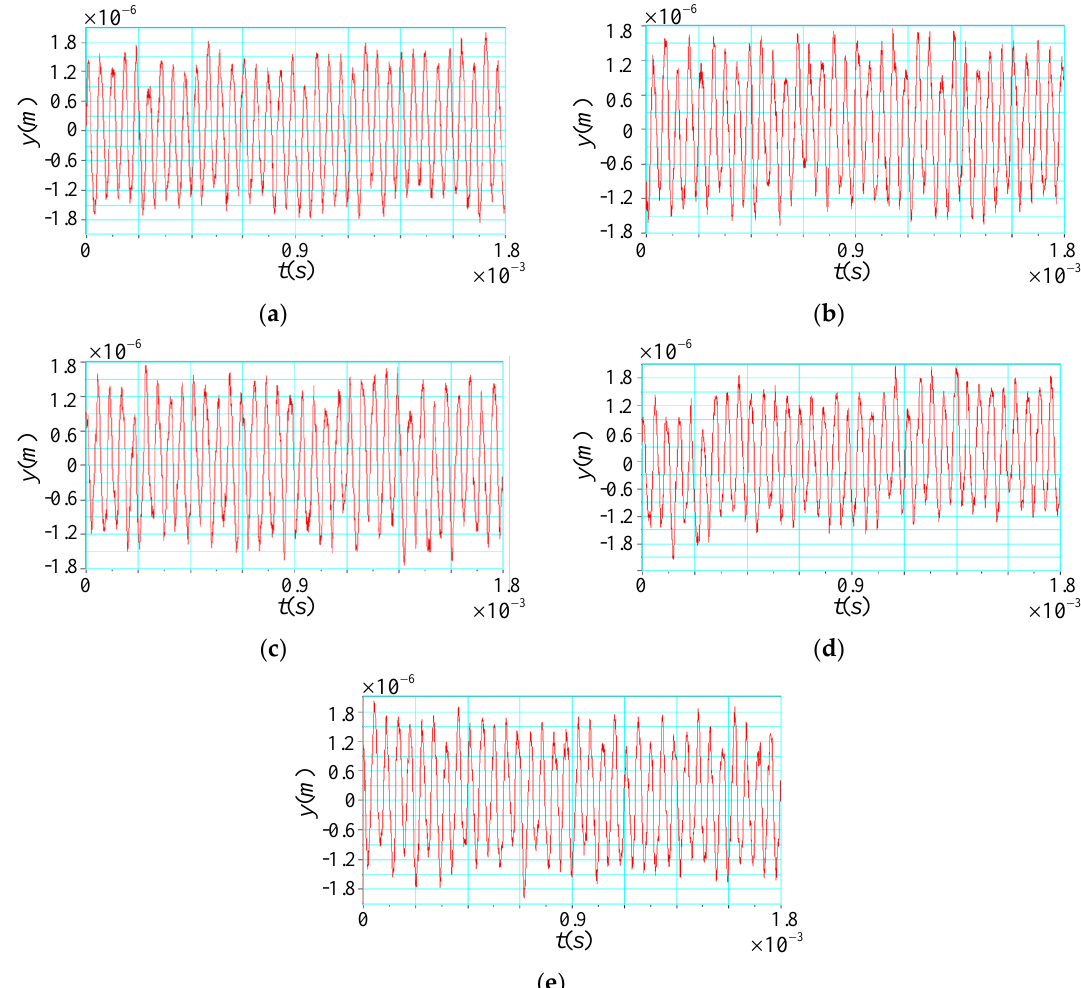
Figure 13. Five large amplitude test points in the touch beam.